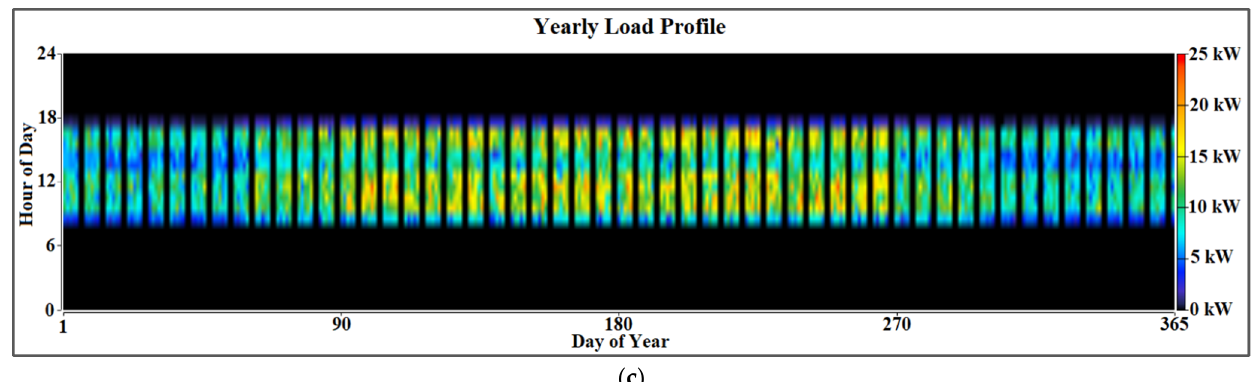
Figure 4. ( a ) Daily load profile; ( b ) annual load profile; ( c ) hourly load profile throughout the year.